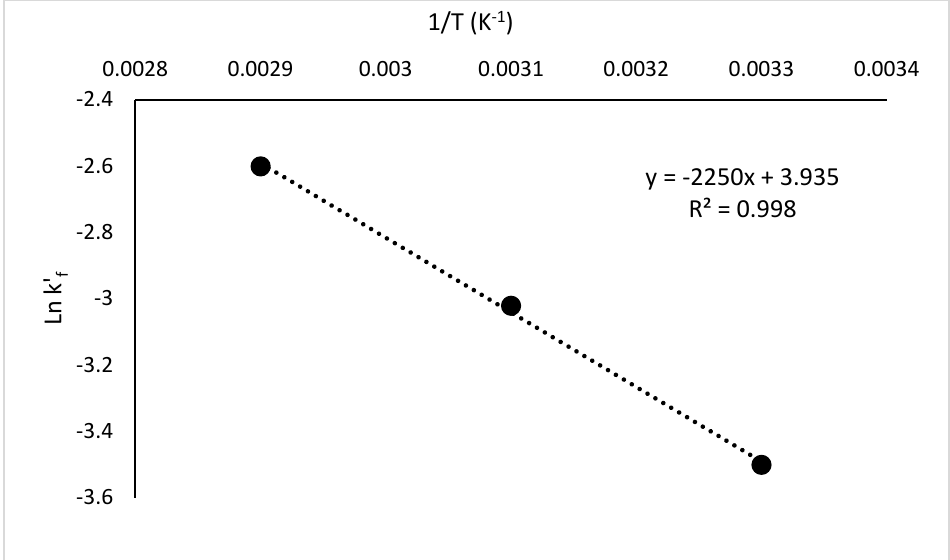
Figure 7. ln  ′ versus 1/T plot for Arrhenius constant and activation energy. Figure 7. ln k (cid:48) versus 1/T plot for Arrhenius constant and activation energy. f Table 4. Values of Arrhenius constant and activation energy. Table 4. Values of Arrhenius constant and activation energy. Parameter Value Unit Pre-exponential factor ( A